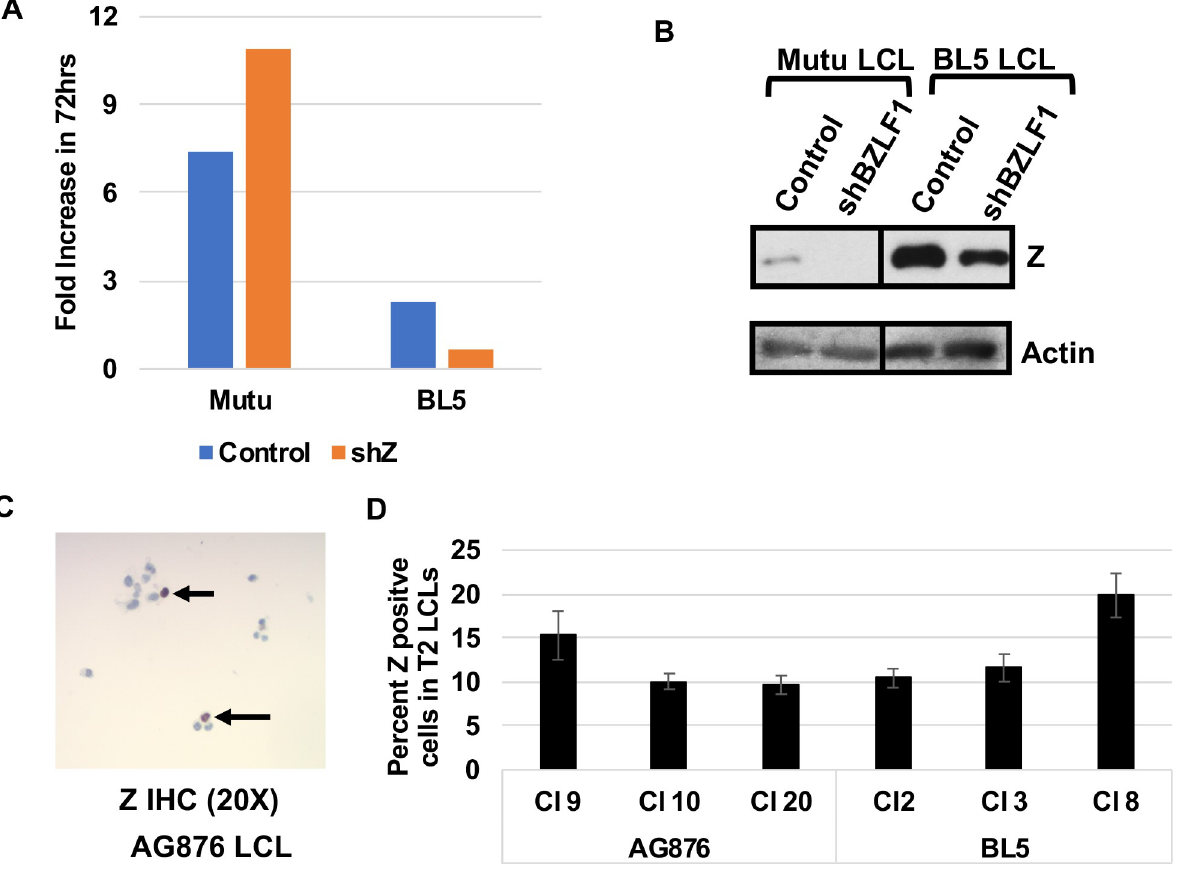
Fig 7. Lytic infection in T2 EBV-infected LCLs does not reduce growth rate. A) T1 EBV-infected (Mutu) or T2 EBV-infected (BL5) LCLs stably infected with control shRNA or shRNAs targeting Z were diluted to 1x10^5 cells and counted 72 hours later. The fold increase in cell number was determined by comparing cell counts at 72 hours to initial cell number. Experiment was performed in triplicate. B) Immunoblot analysis of BL5 LCLs or Mutu LCLs infected with either control shRNA or shRNA targeting Z using antibodies against Z and actin. C) IHC analysis of T2 LCLs was performed using antibody against Z. Arrows indicated Z staining cells. D) Quantification of the percent of EBV-infected cells in type 2 LCLs expressing Z as determined by IHC analysis. At least 10 fields of view were quantified across 3 independently derived Type 2 LCL clones infected with either the AG876 or BL5